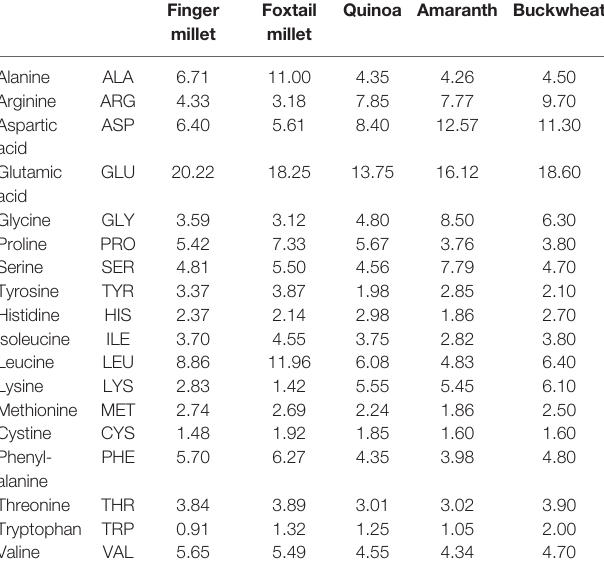
TABLE 3 | Amino acid pro fi le (g/100 g